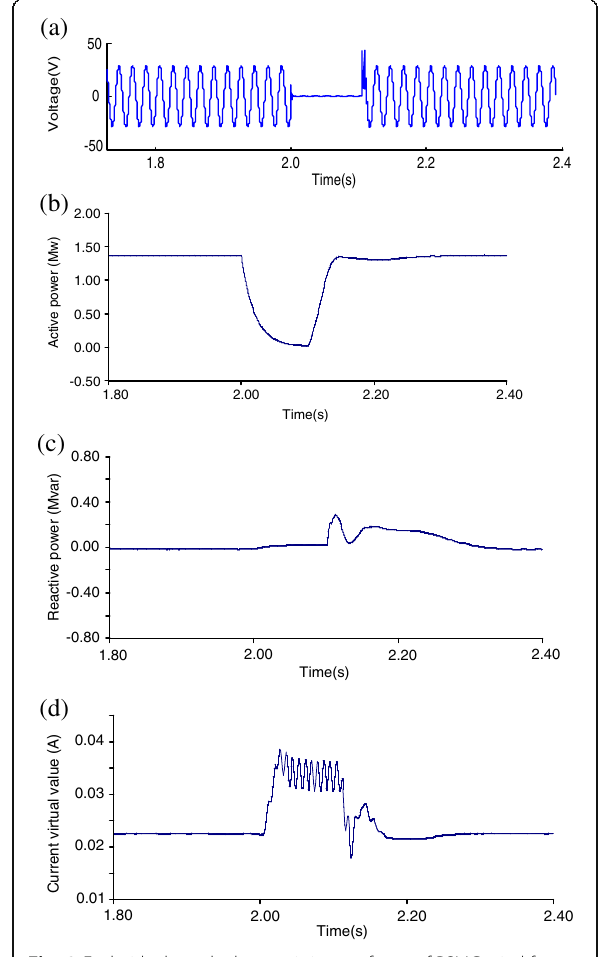
Fig. 3 Fault ride through characteristic waveforms of PSMG wind farm with threephase short-circuit: a voltage, b active power, c reactive power, d machine terminal current RMS